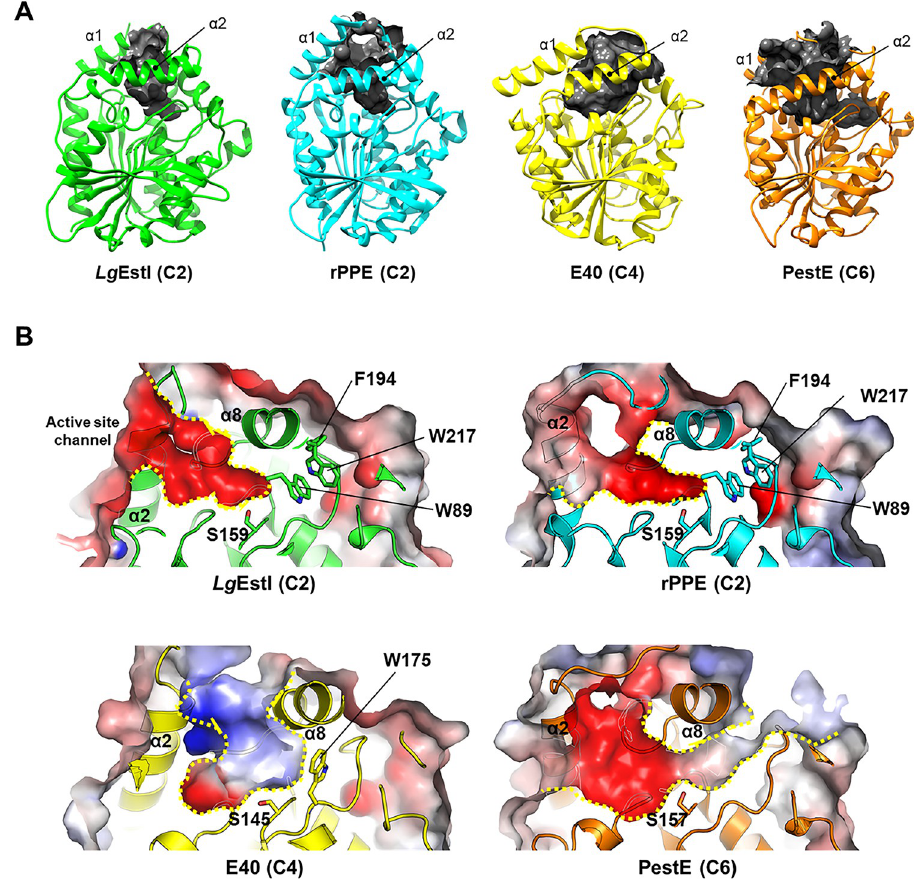
Fig 4. Comparison of the substrate access channel. (A) The surface area and volume of esterase and lipase based on the molecular surface are represented with black surfaces. The Computed Atlas of Surface Topography of proteins (CASTp) was employed to determine protein volume (probe radius of 1.4 Å ). (B) Electrostatic potential surface and diagrammatic representation of the substrate access channel of the enzymes. The surface charge distribution is displayed as blue for positive, red for negative, and white for neutral. The channel of each enzyme is highlighted with yellow dots. Bulky residues blocking the channel of Lg EstI, rPPE, and E40 are indicated with sticks. entrance to the outer surface [33]. Ser157 is located in the middle of a narrow tunnel for sub- strate cleavage. However, Lg EstI and rPPE (C2) have shallow substrate tunnels. When com- pared with PestE (C6), Trp89, Phe194, and Trp217 of Lg EstI and rPPE protrude into the tunnel. Therefore, the tunnel observed in PestE is blocked by bulky residues in Lg EstI and rPPE. Tunnel blocking by a bulky residue (Trp175) is also observed in E40 (C4) (Fig 4B). Therefore, the limited space available for Lg EstI may hinder the access of substrates with long acyl carbon chains. Area expansion of the acyl binding pocket located at the bottom of the active site changes the substrate preference of rPPE [31]. Structural and activity analyses of rPPE revealed that the mutation of W187H increased the volume of the acyl chain pocket and changed the substrate preference from short p NA to pNB, which has a long acyl carbon chain [31, 34]. In conclusion, Lg EstI exhibits substrate specificity against p NA owing to its narrow binding site and blocked tunnel, which favors short acyl chains. Structural comparison indi- cated that the cavity channel of the esterase/lipase was wider and longer as the length of the substrate acyl chain increased.